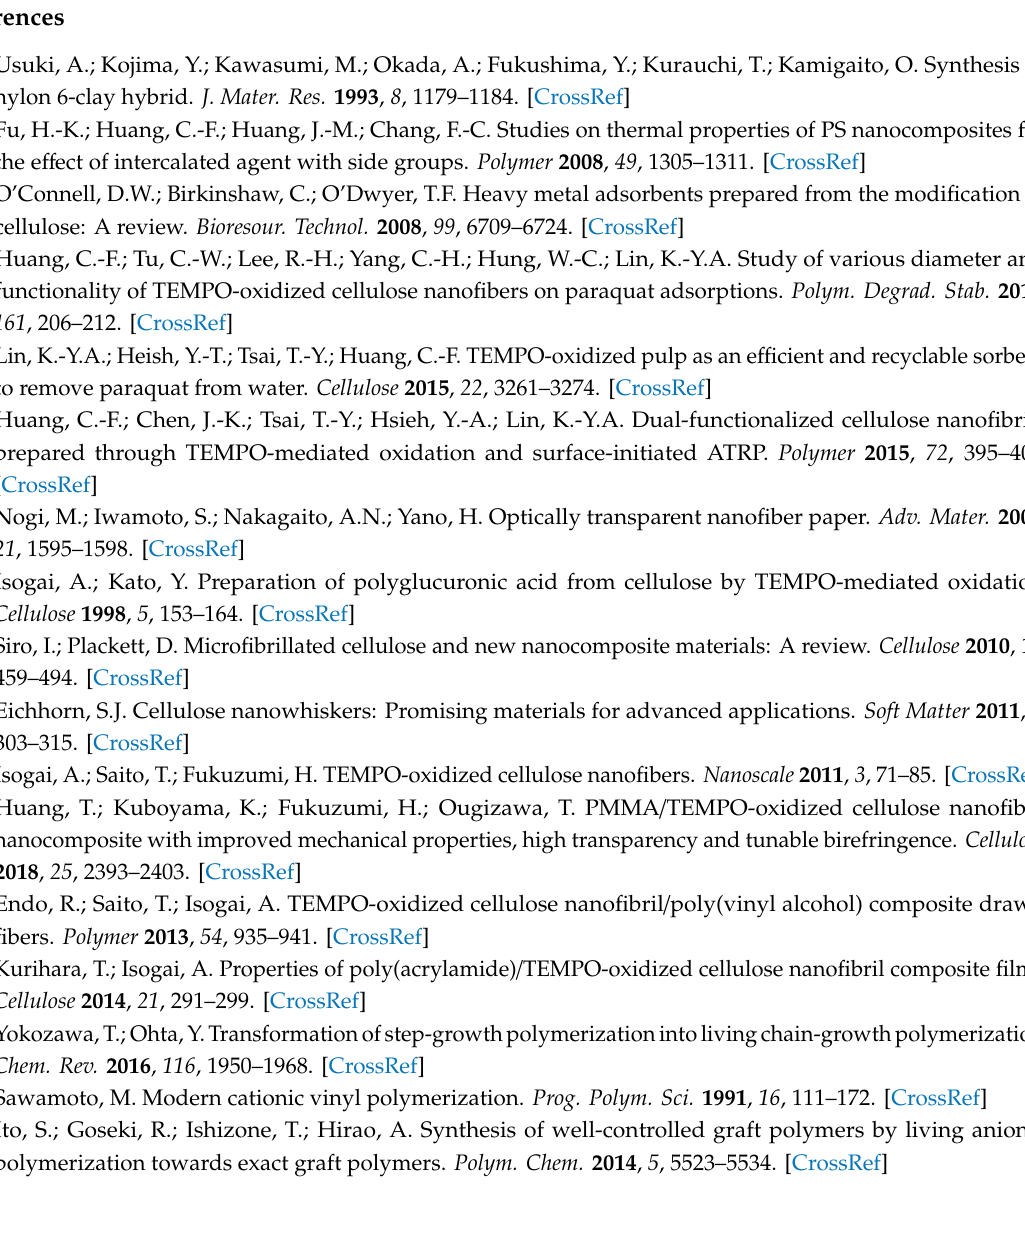
Figure S1: Apparent images of TOCN– g –PMMA powders prepared by (a) SI ICAR ATRP (167 ppm copper) vs (b) SI normal ATRP (2000 ppm copper); Figure S2: FT-IR spectra (4000–400 cm − 1 ) of (a) TOCN– g –PMMA and (b) pure PMMA; Figure S3: FT-IR calibration line based on the absorption intensity ratios of characteristic peaks of TOCN / PMMA blends and TOCN– g –PMMA2 sample; Figure S4: Dispersion photos of TOCN– g –PMMA2 (10 mg) in di ff erent solvents (3 mL) in (a) 10 min and (b) 24